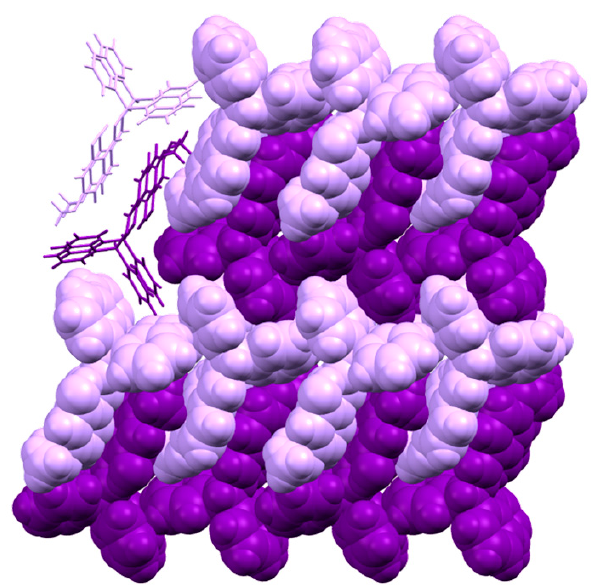
Figure B6. Packing diagram for mvanadpm .